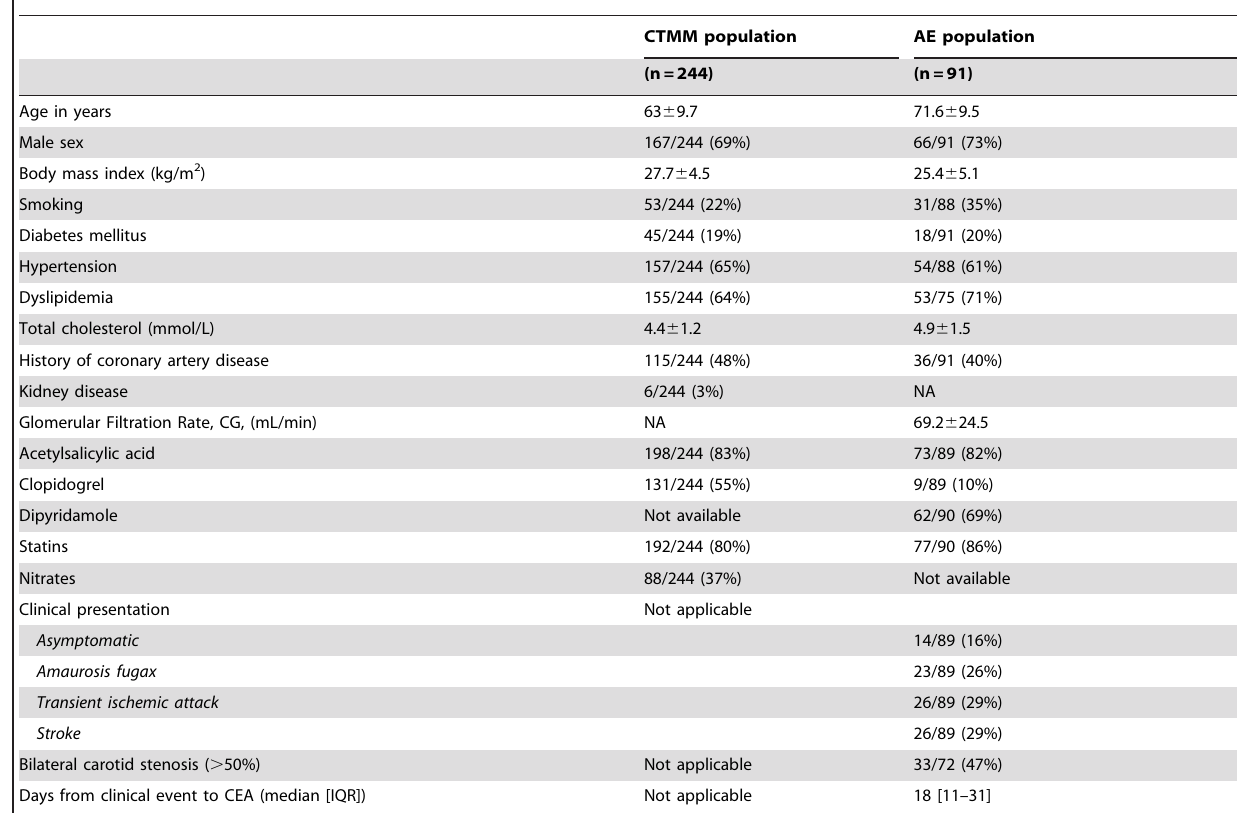
Table 1. Baseline